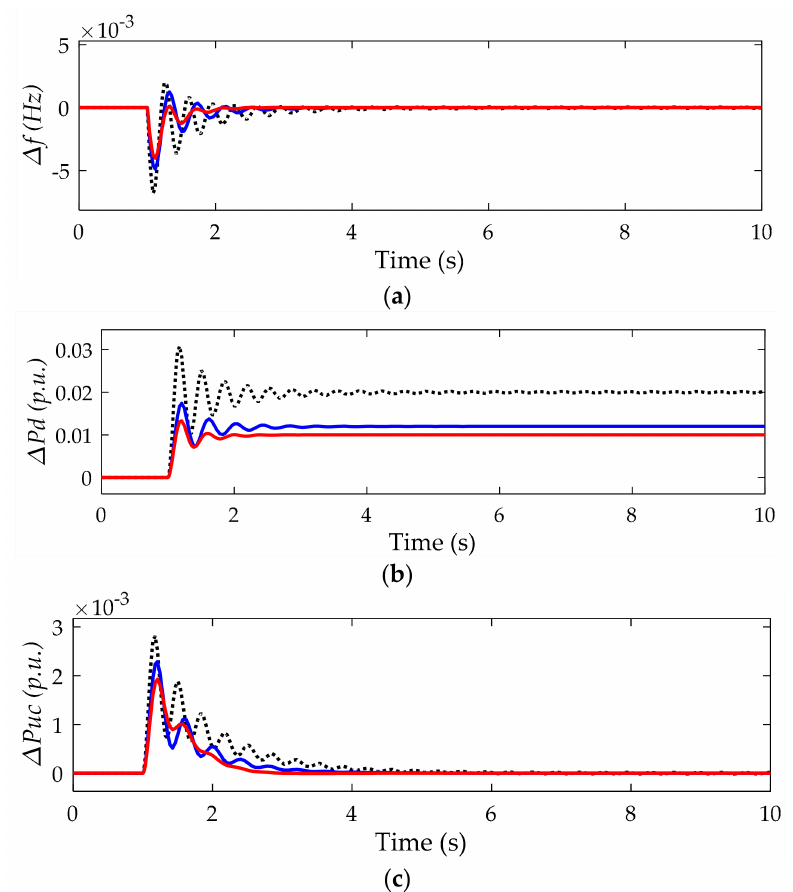
Figure 9. The system outputs with step signal, proportion integral derivative (PID) control (black), H ∞ control (blue) and µ -synthesis control (red), ( a ) frequency deviation; ( b ) diesel engine power deviation; ( c ) ultra-capacitor power